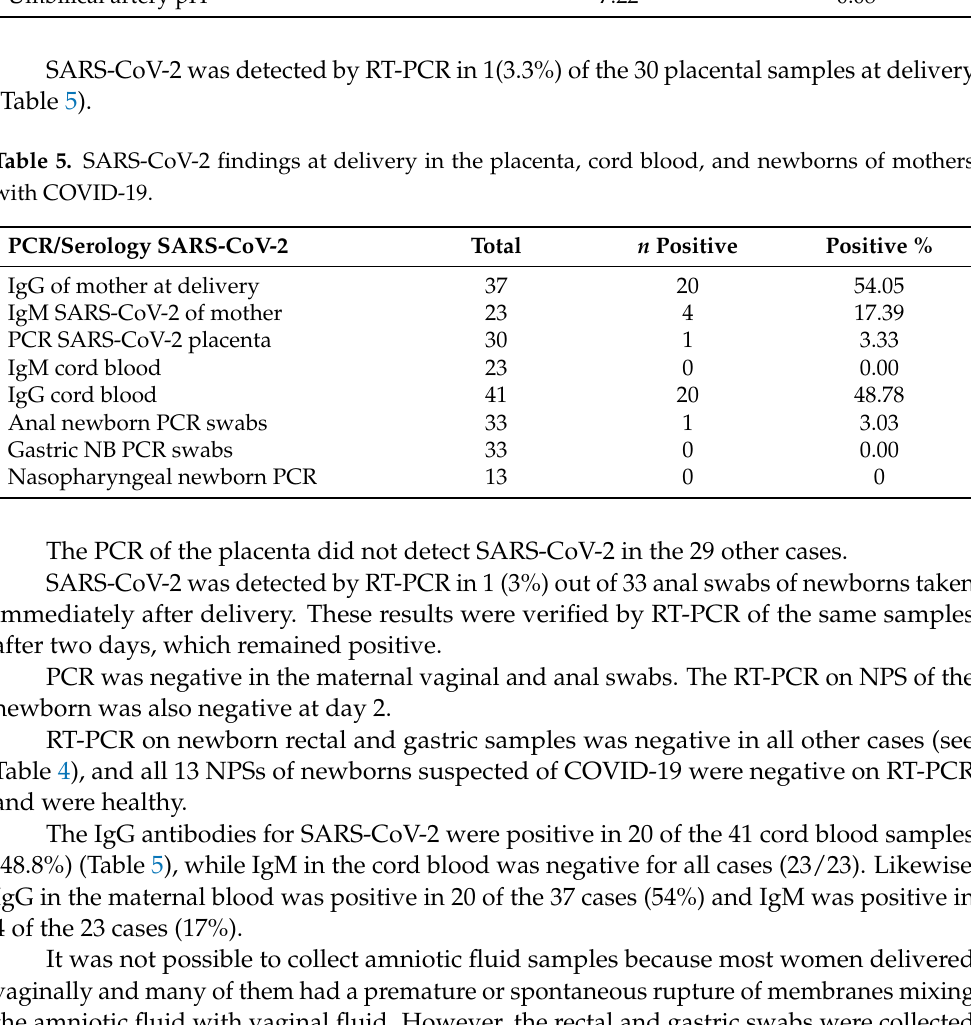
Outcomes/N Standard Deviation